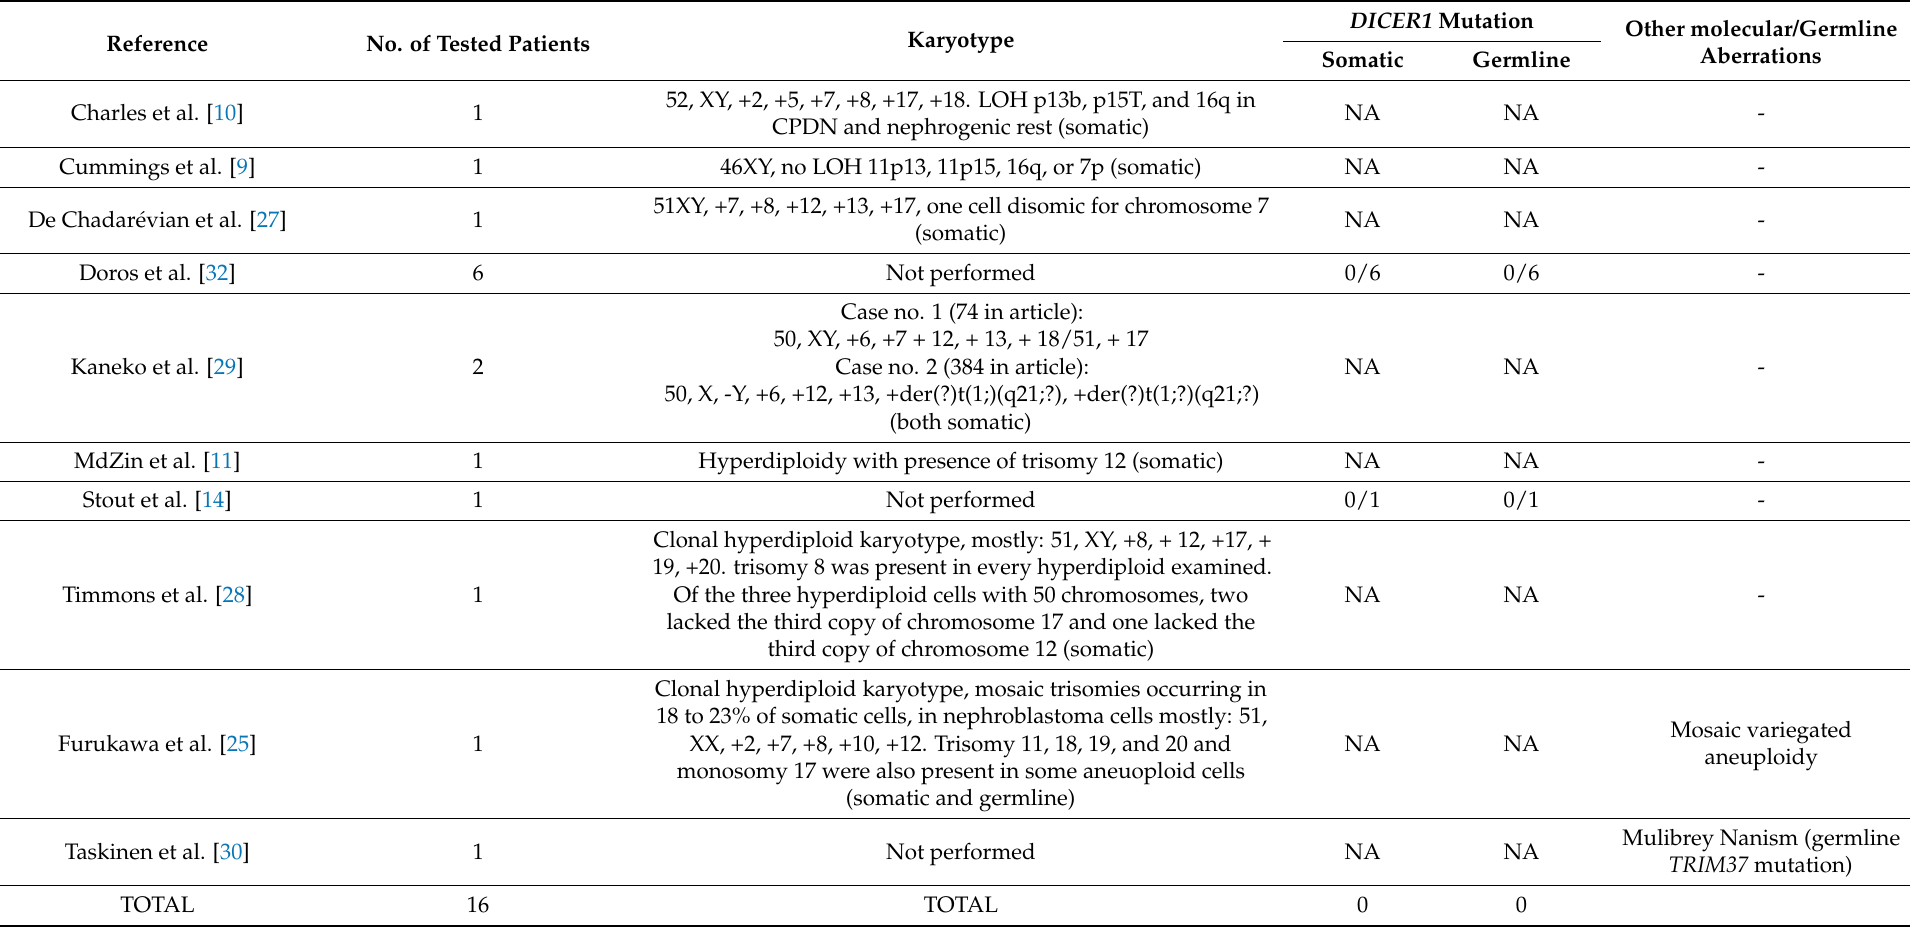
Table 4. Molecular testing and genetic predisposition in tested patients with